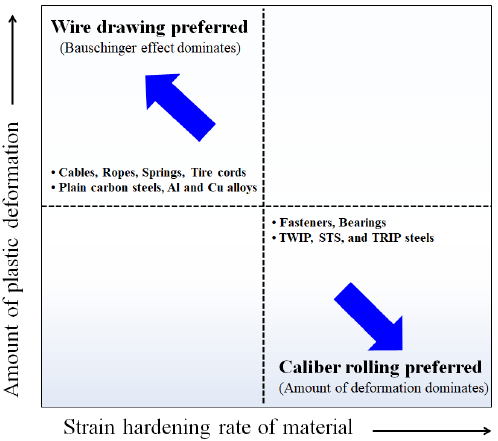
Figure 17. Schematic map of the appropriate process selection considering the strain hardening rate of materials and the amount of plastic